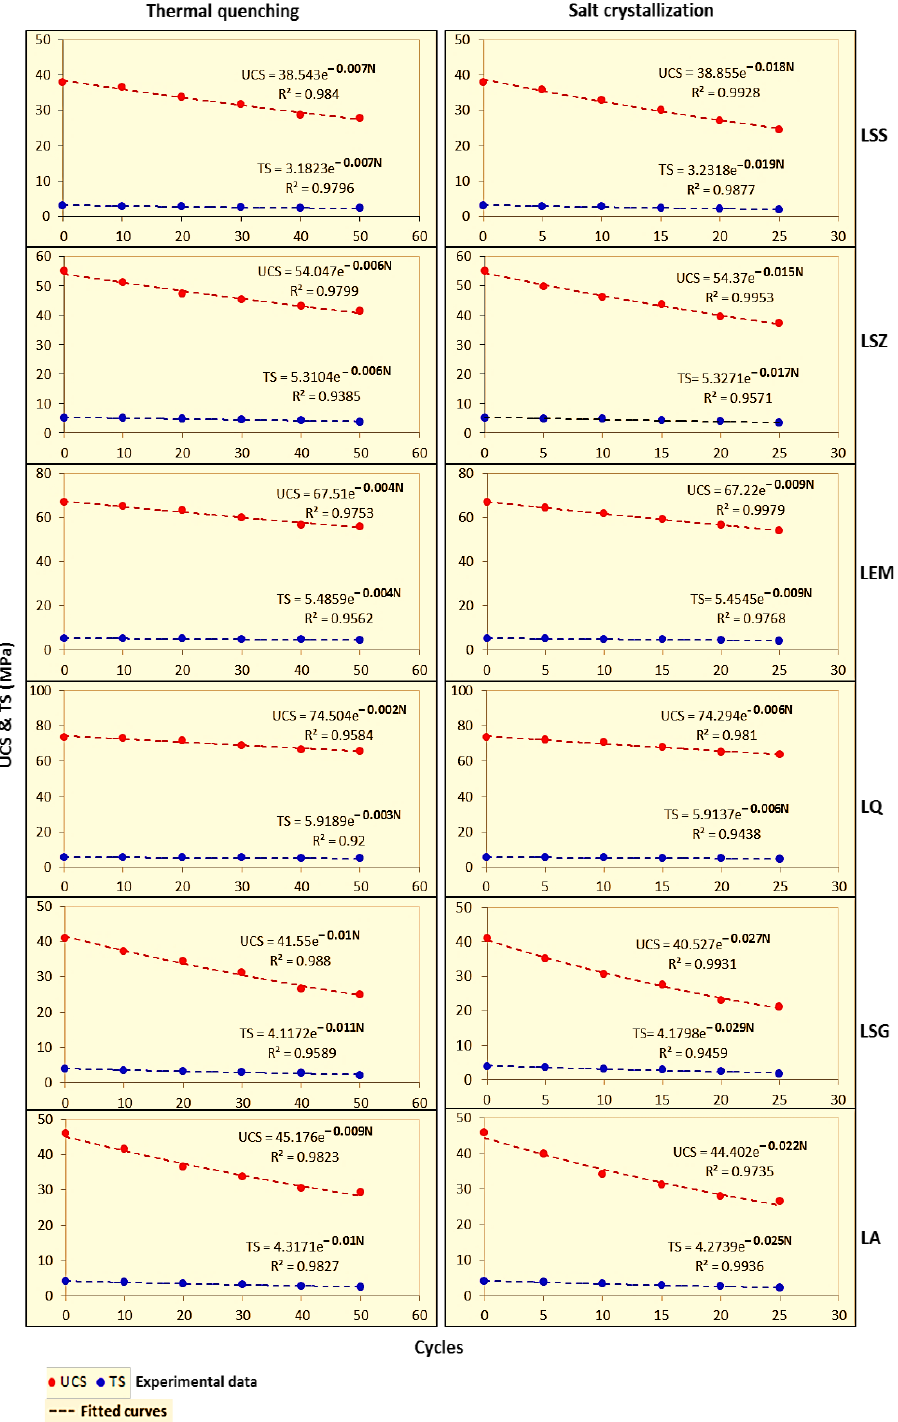
Figure 8. Determining decay constant ( λ ) based on TS and UCS data against cyclic thermal and salt weathering.